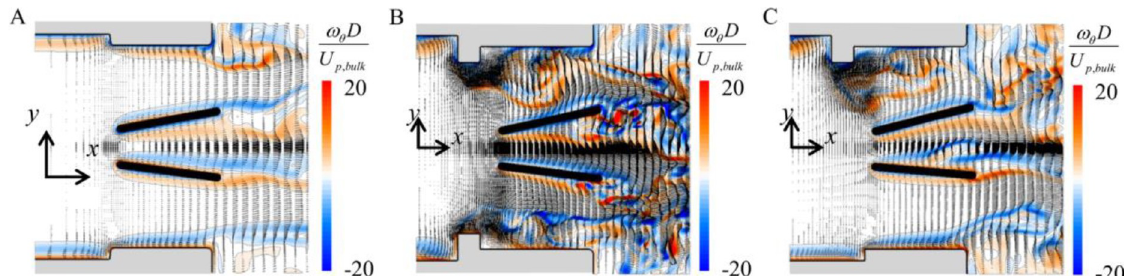
Fig 6. Contours of the instantaneous azimuthal vorticity and instantaneous velocity vectors on an ( x - y ) plane at t / T = 9.60 ( h = 0.12 D ). (A) no pannus. (B) Circular pannus. (C) Upper semi-circular pannus.